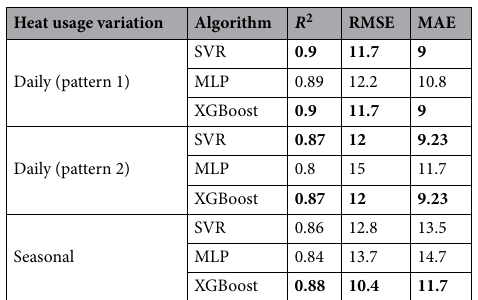
Table 3. Overall heat usage prediction performance using different ML algorithms on the validation dataset. Significant values are in bold.